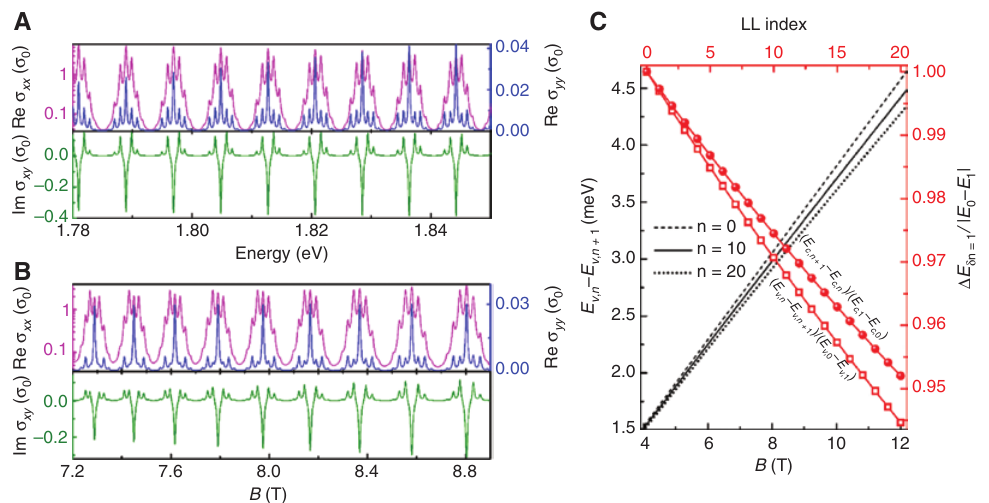
− E (black solid and broken lines), for clarity, only conditions with LL index n = 0, v , n v , n + 1